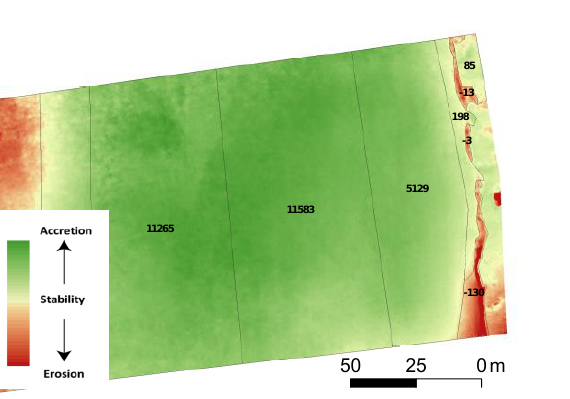
Figure 9: Example of a DDVM with polygons and zonal statistics. Units are in m 3 .